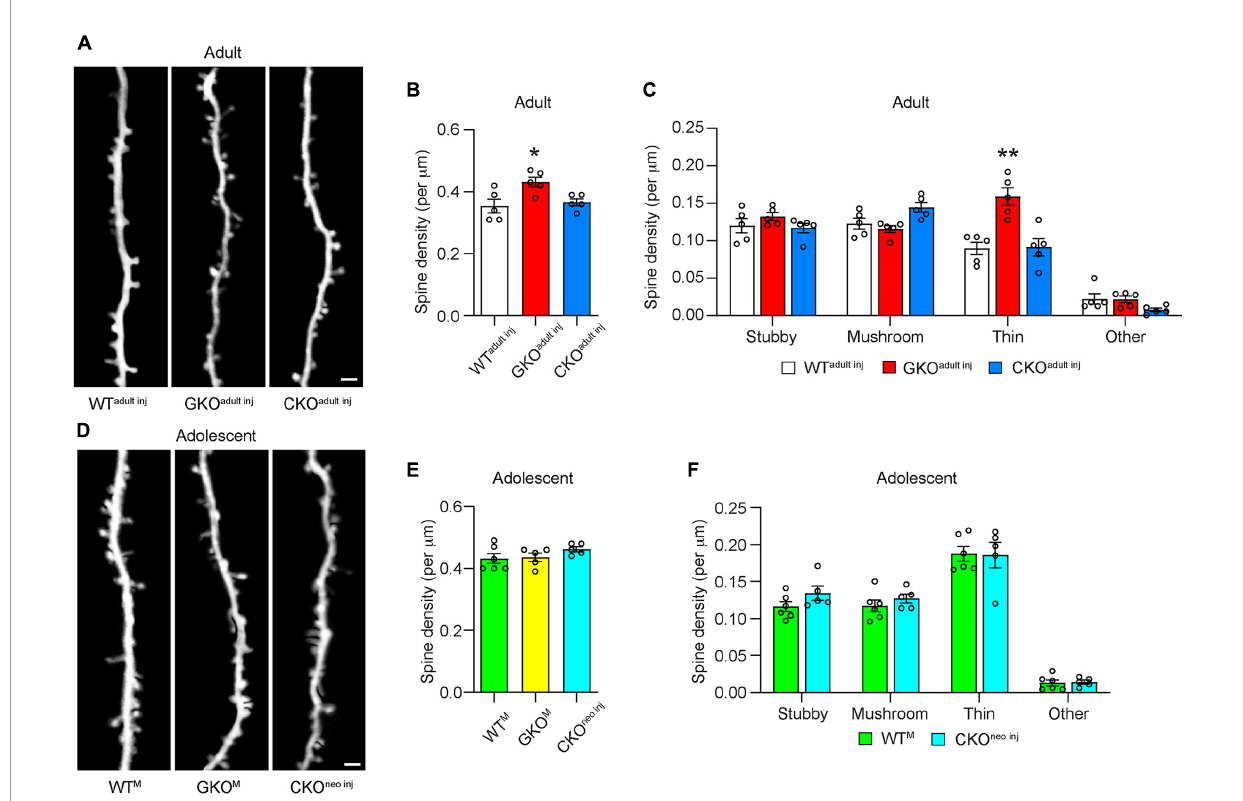
FIGURE2 Cell-autonomous Fmr1 knockout (KO) in adolescence or adulthood does not alter spine density. (A) Examples of dendritic spines imaged in vivo in adult mice. (B) Total spine density in WT adult inj , global knockout (GKO adult inj ), and conditional knockout (CKO adult inj ) mice. n = 5 per group. (C) Density of different types of spines in WT adult inj , GKO adult inj , and CKO adult inj mice. n = 5 per group. (D) Examples of dendritic spines imaged in vivo in adolescent mice. (E) Total spine density in adolescent mice. n = 6 for WT M , 5 for GKO M , and CKO neo inj mice. (F) Density of different types of spines in adolescent mice. n = 6 for WT M and 5 for CKO neo inj mice. Scale bar = 2 µ m. Hereinafter * p < 0.05, ** p < 0.01; post-hoc comparisons with the control